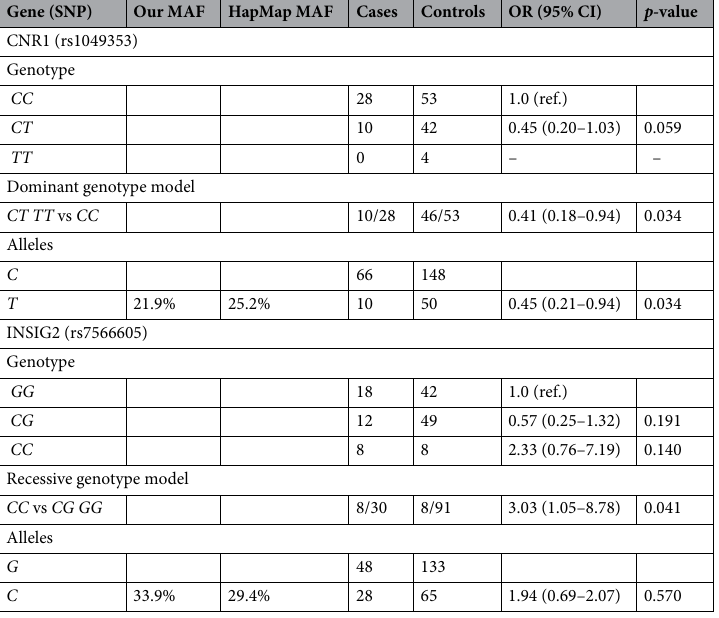
Table 4. Genotypic and allelic frequencies of the CNR1 (rs1049353) and INSIG2 (rs7566605) polymorphisms associated with weight gain in patients treated with